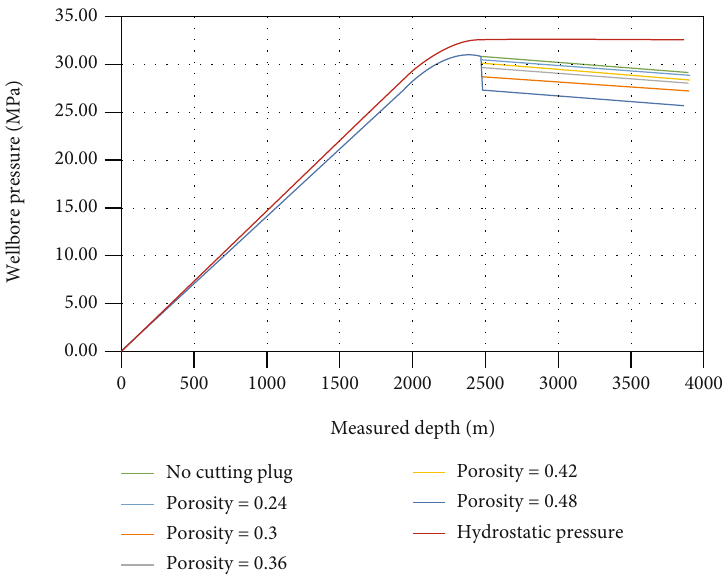
Figure 9: The e ff ect of cutting plug porosity on the wellbore pressures in a closed pipe condition.